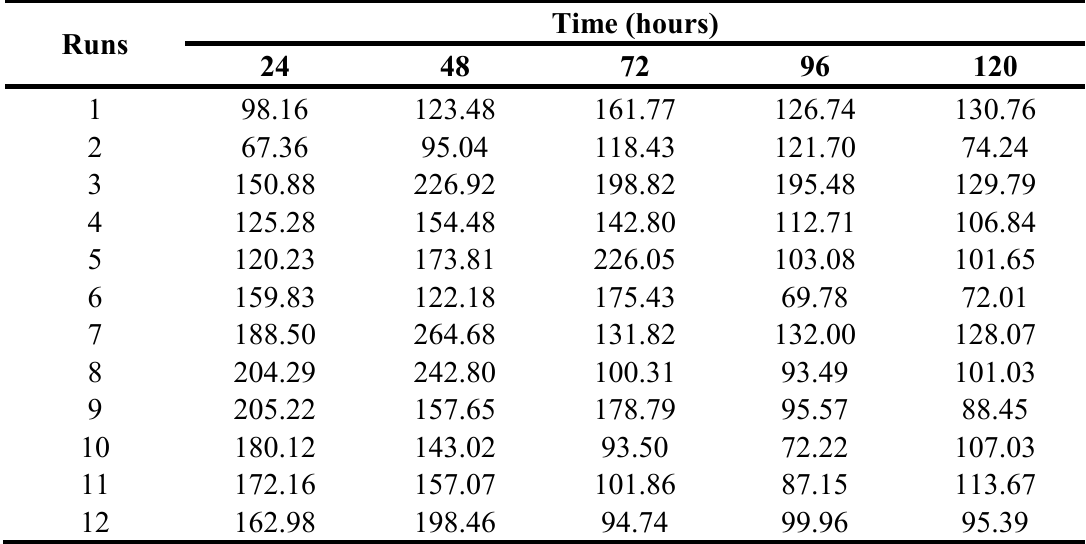
Table 1. Phytase activity (U/g) in SSF during 120 hours of fermentation by Lichtheimia blakesleeana URM5604 using citrus pulp as